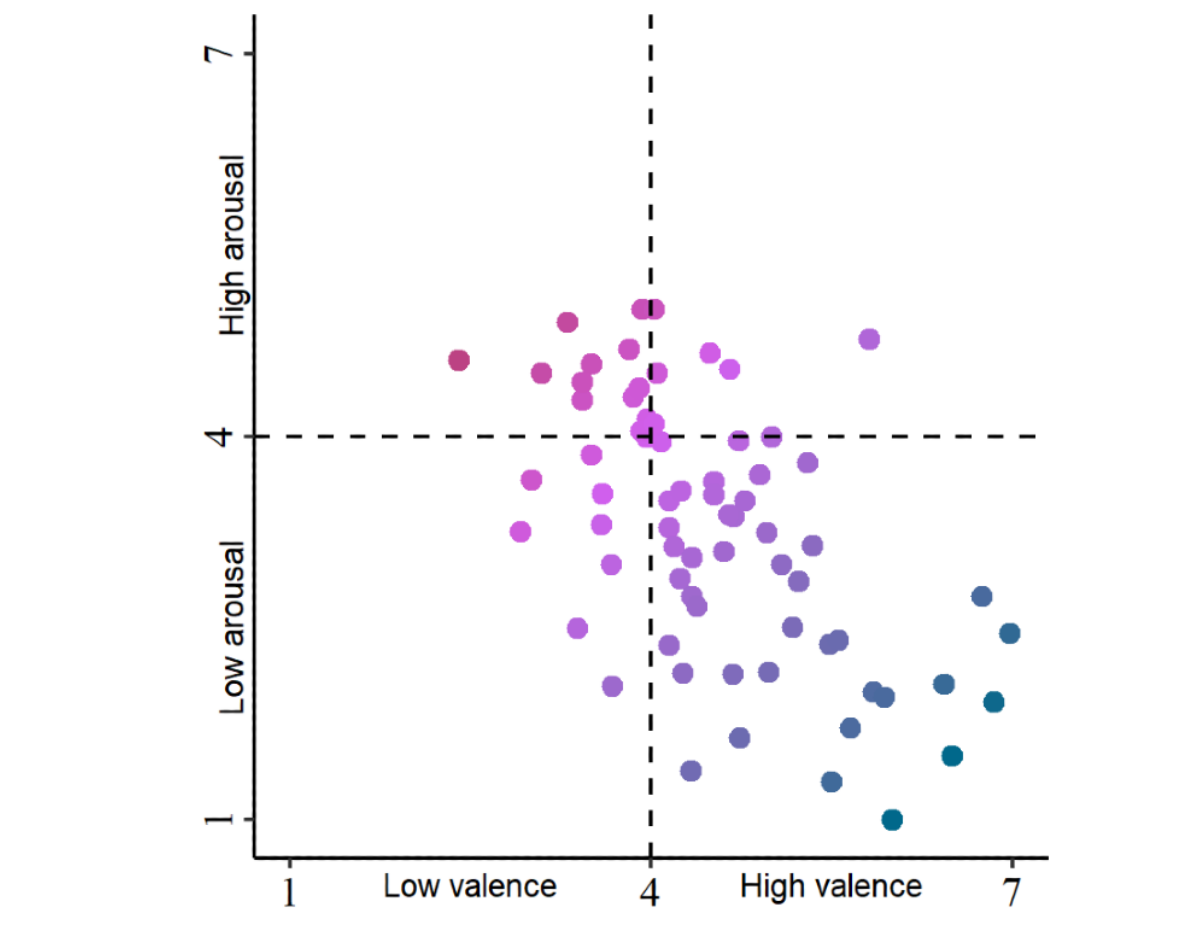
Figure 1. Perceived valence and arousal by subject. Shown are the average self-reported valence and arousal levels by subject in the field study. Red points indicate high levels and blue points indicate low levels of average